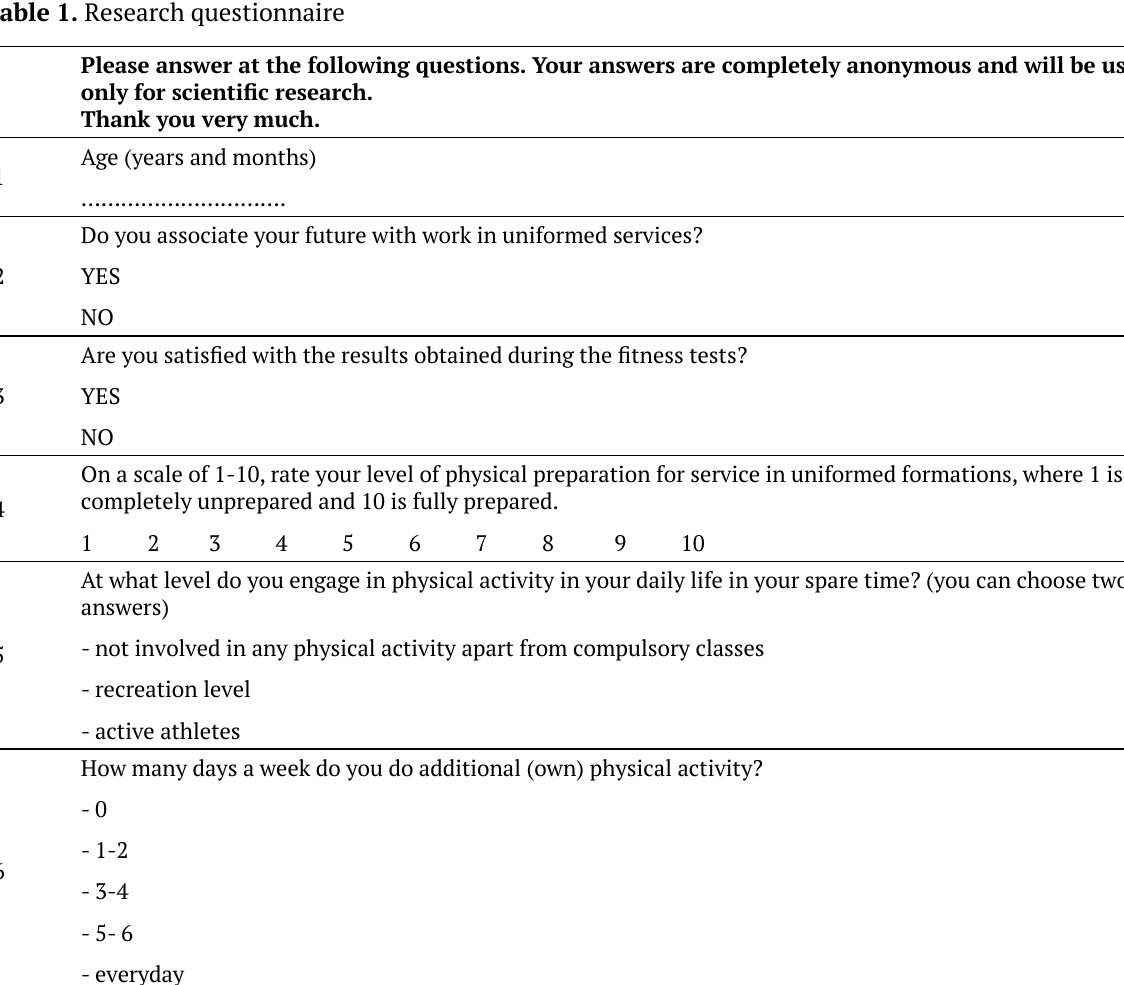
Table 2. Results of fitness tests of students of specialization Physical Education in uniformed services